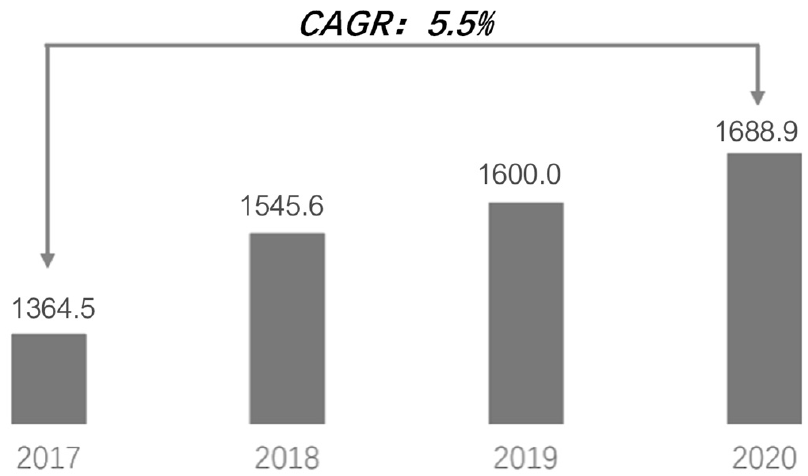
Figure 4. IoT spending in China from 2017 to 2020 (Unit: USD/billion).